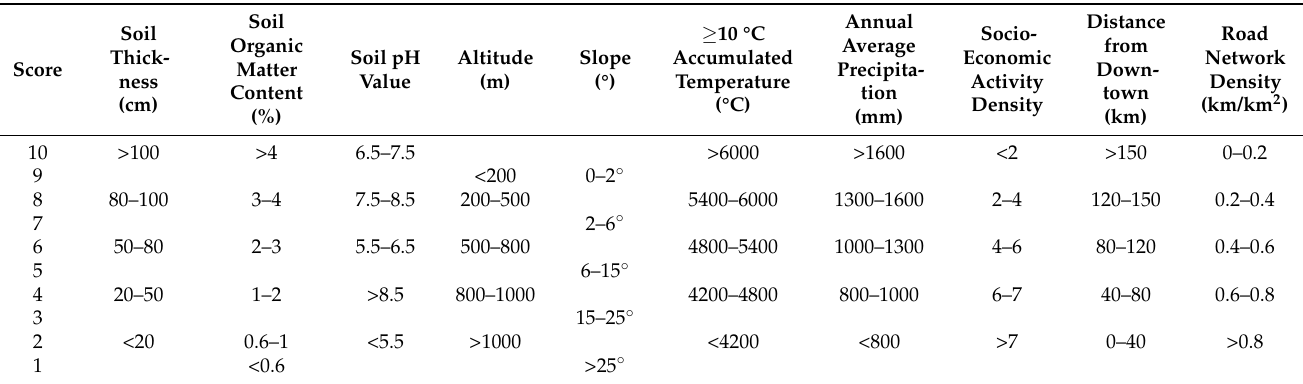
Table 3. Criterion scores for